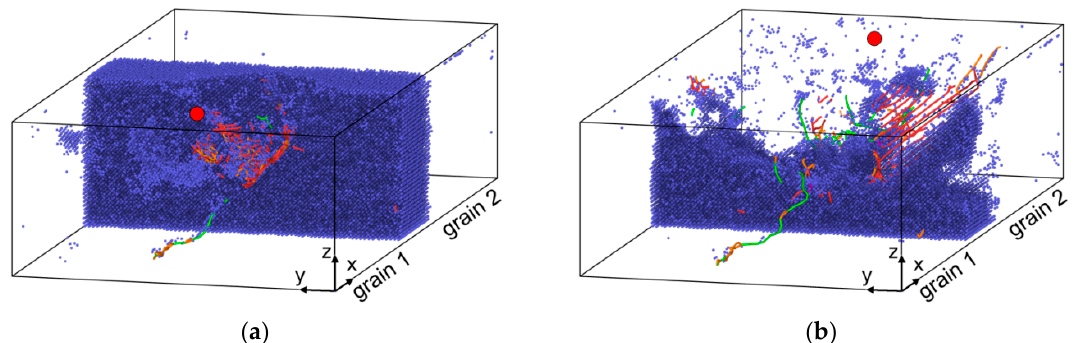
Figure 10. Snapshots displaying the resulting structure of the model Ti crystallite with the Figure10. SnapshotsdisplayingtheresultingstructureofthemodelTicrystallitewiththevanadium-free β -Ti inclusion after 10 ( a ) and 37 nm ( b ) of scratching. BCC atoms are shown as blue dots. Colored vanadium-free β -Ti inclusion after 10 ( a ) and 37 nm ( b ) of scratching. BCC atoms are shown as blue dots. Colored curves denote the dislocations cores. Dislocations with the Burgers vectors b 1 = 1 ⁄ 3 curves denote the dislocations cores. Dislocations with the Burgers vectors b 1 = 1⁄3 (cid:68) (cid:69) 〈12(cid:3364)10〉 are shown in orange and green, respectively. Other dislocation lines are 〈11(cid:3364)00〉 and b 1210 are shown in orange and green, respectively. Other dislocation lines are shown in red. Only the 2 = 1 ⁄ 3 shown in red. Only the dislocations generated in HCP-Ti are shown. The large red dot marks the dislocations generated in HCP-Ti are shown. The large red dot marks the position of the position of the indenter.